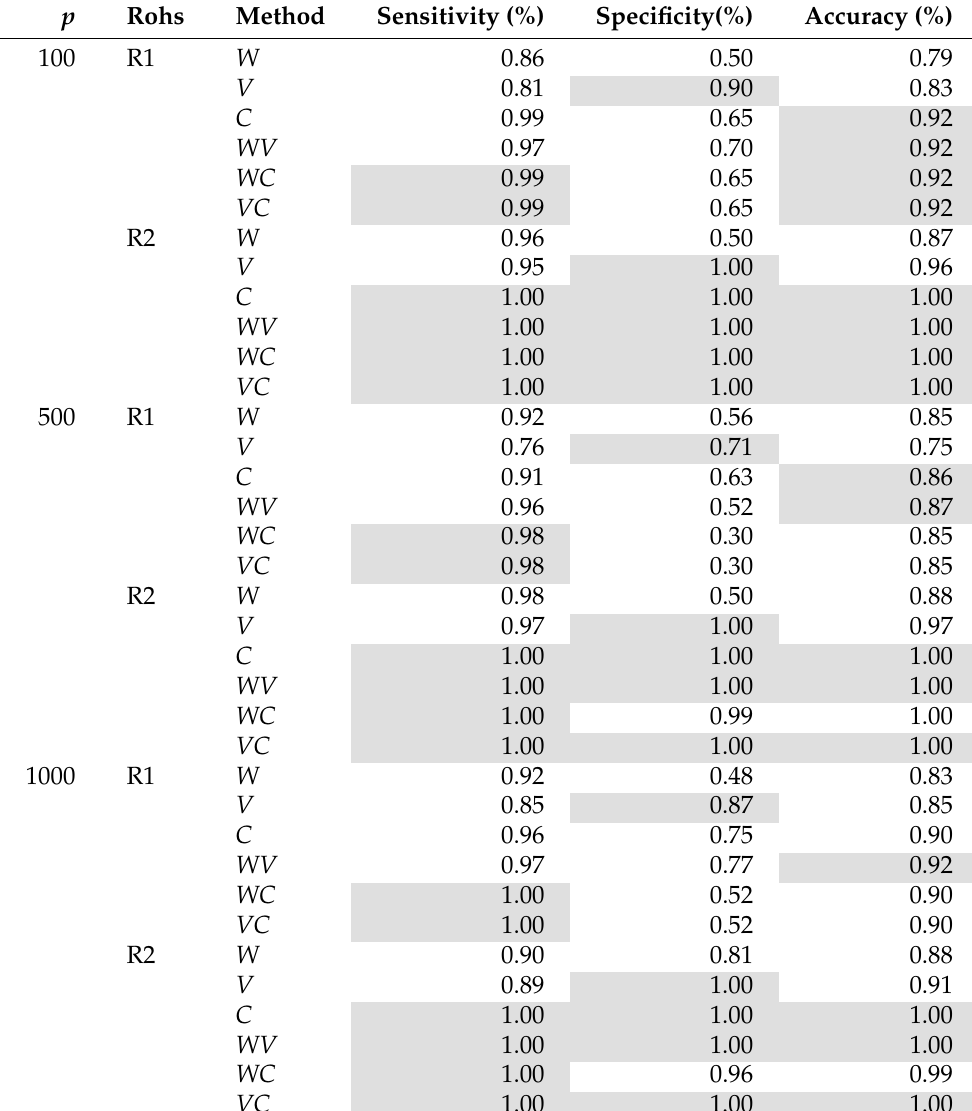
Table 1. The sensitivity, specificity, and accuracy of selected variables by reference and proposed method are presented in comparison to all simulation designs considered. The cells with the highest sensitivity, specificity, and accuracy within each simulation design are highlighted in